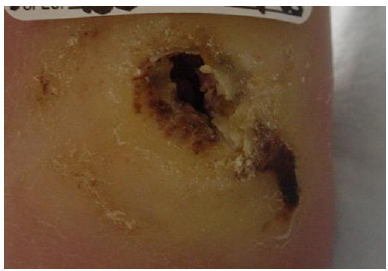
Figure 1. Wound appearance at initial visit.